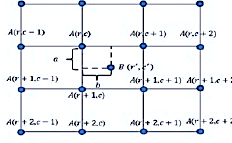
Fig. 3. Resize image with Bicubic interpolation method